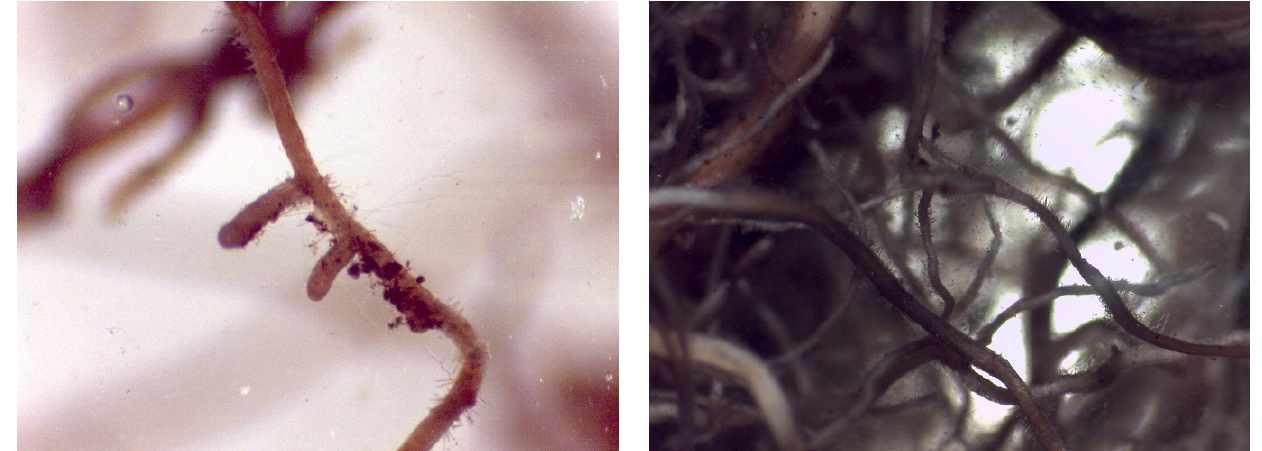
Figure 5. Detail of a short root of a Nothofagus alessandrii plant inoculated with Thelephora terrestris ( left ) and root of a Nothofagus alessandrii plant without inoculation ( right ).